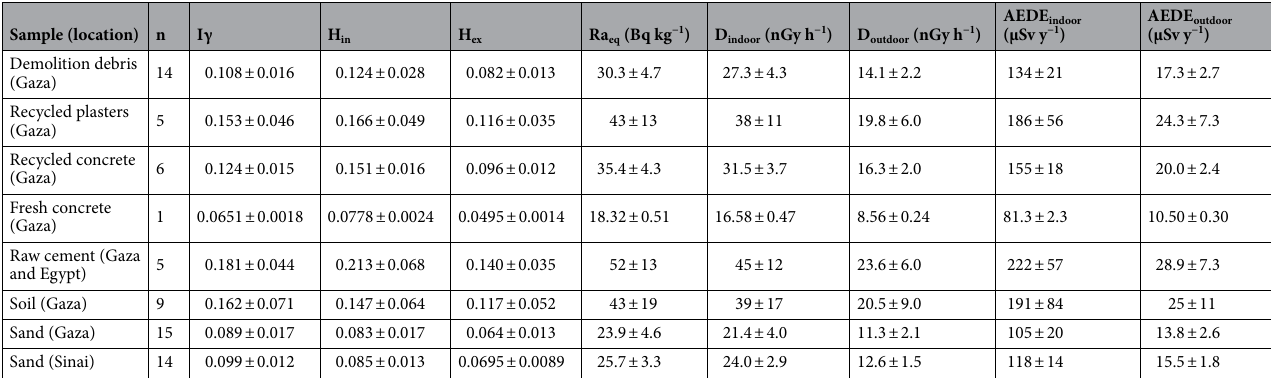
Table 5. Radiological hazard indices calculated for building material, soil and sand samples (mean ± standard deviation), Fresh concrete (Gaza) ± : combined uncertainty, n: number of